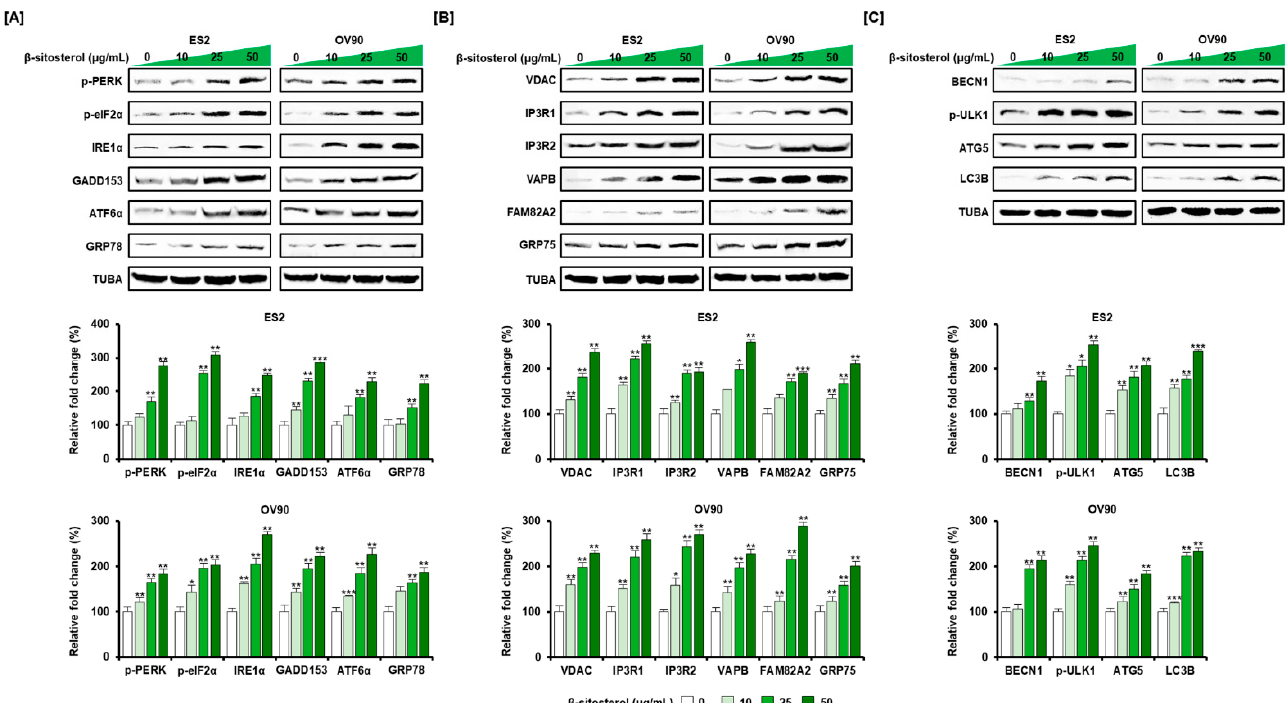
Figure 4. Increased expression of ER stress sensors and ER-mitochondrial axis and autophagy proteins by β -sitosterol in ovarian cancer cells. Western blot bands of UPR proteins ( A ) including protein kinase R (PKR)-like endoplasmic reticulum kinase (PERK), eukaryotic translation initiation factor 2 α (eIF2 α ), inositol-requiring enzyme-1 α (IRE1 α ), growth arrest and DNA damage 153 (GADD153), activating transcription factor 6 α (ATF6 α ), 78 kDa glucose-regulated protein (GRP78), ER-mitochondrial axis proteins ( B ) voltage-dependent anion channel (VDAC), IP3 Receptor 1 (IP3R1), IP3 Receptor 2 (IP3R2), vesicle-associated membrane protein (VAPB), regulator of microtubule dynamics 3, RMDN3 (FAM82A2), glucose-regulated protein 75 (GRP75), and autophagy proteins ( C ) beclin 1 (BECN1), UNC-51-like kinase 1 (ULK1), autophagy-related 5 (ATG5), autophagy marker Light Chain 3 B (LC3B) after β -sitosterol (0, 10, 25, and 50 µg/mL) treatment. Alpha-tubulin (TUBA), used as a control, is shown at the bottom of each set. The asterisks indicate significant differences between treated and control cells (*** p < 0.001, ** p < 0.01, and * p < 0.05).